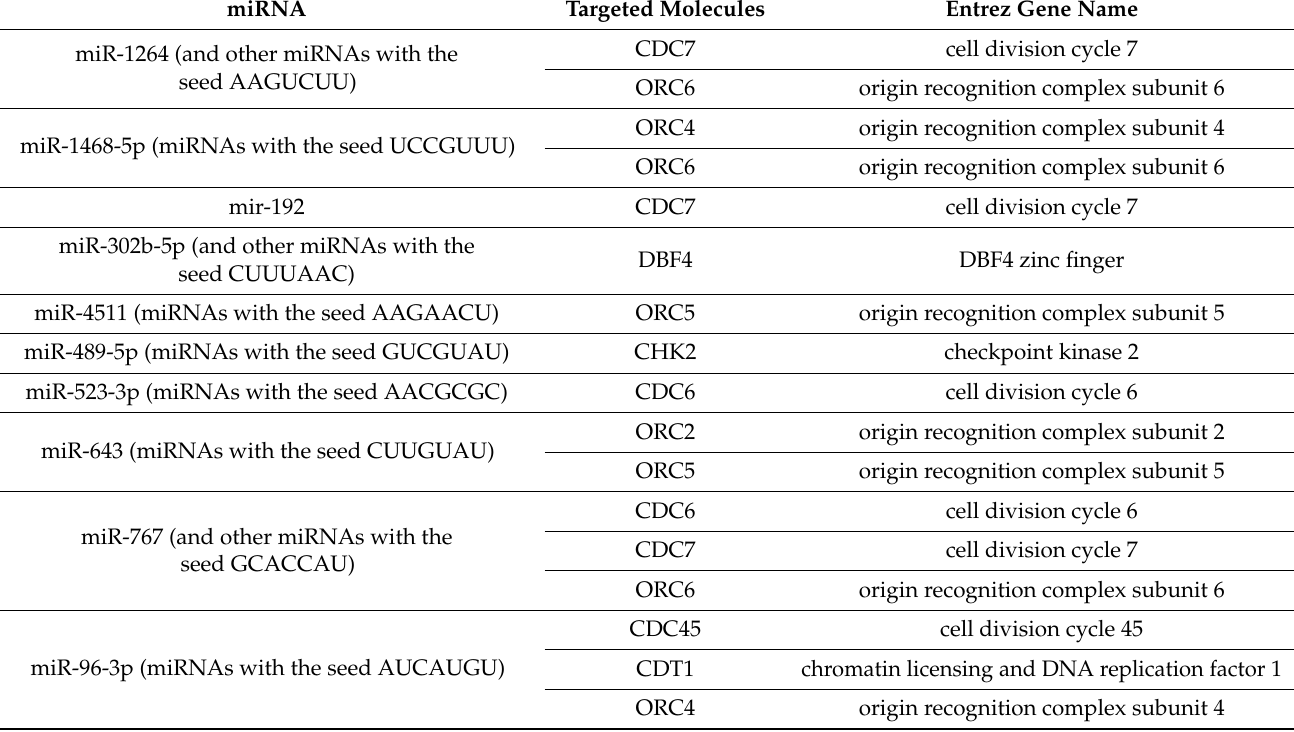
Table 2. Direct relationships of miRNAs and targeted molecules in cell cycle control of chromosomal replication. miRNA Targeted Molecules Entrez Gene Name CDC7 miR-1264 (and other miRNAs with the seed AAGUCUU) ORC6 origin recognition complex subunit 6 ORC4 miR-1468-5p (miRNAs with the seed UCCGUUU) mir-192 CDC7 miR-302b-5p (and other miRNAs with